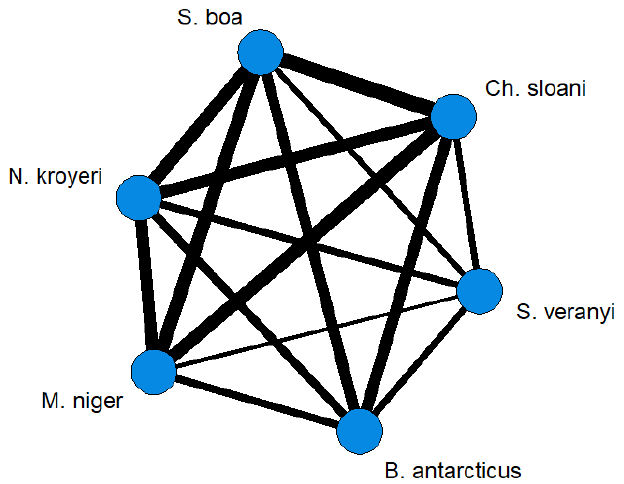
Figure 7. Network graphs based on pairwise comparisons (ANOSIM) between mesopelagic fishes ( Stomias boa , Malacosteus niger , Chauliodus sloani , Borostomias antarcticus, and Notoscopelus kroyeri ) across the depth gradient in the Irminger Sea (North Atlantic). Note: the “thicker” the line is connecting two species, the “stronger” the relationship is (lower R in pairwise ANOSIM comparisons between species).